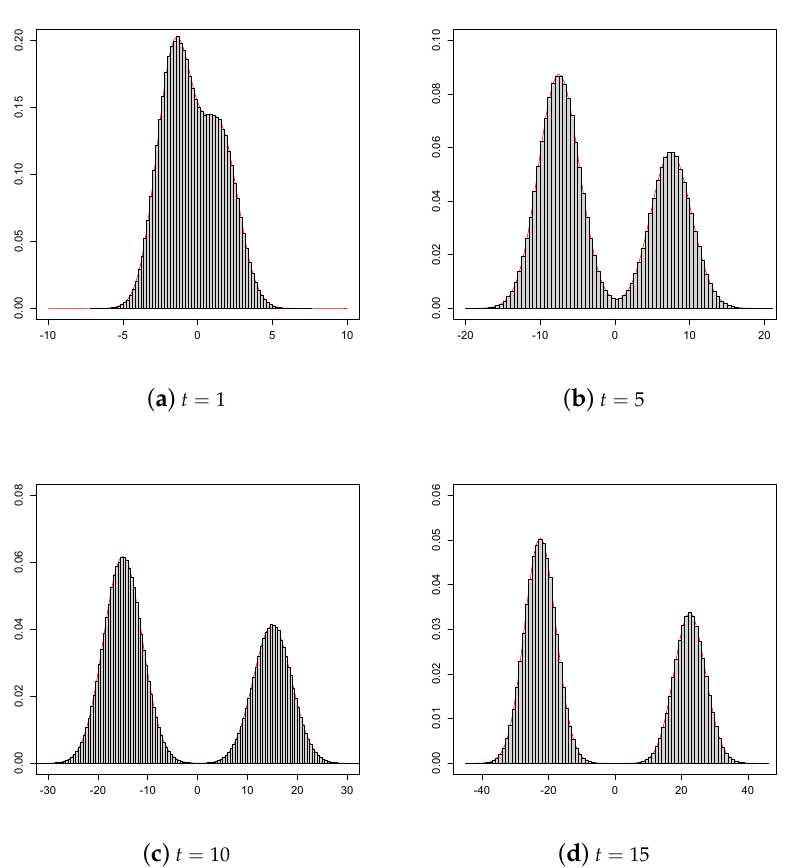
Figure 4. For the process Z ( t ) , having infinitesimal moments (51), with ( y , τ ) = ( 0,0 ) and ϑ = 0.4, γ = 1.5, ν = 0.1, Q = 2, the transition pdf (37) as a function of x is superimposed over a histogram obtained via Algorithm 1 for different choices of t .